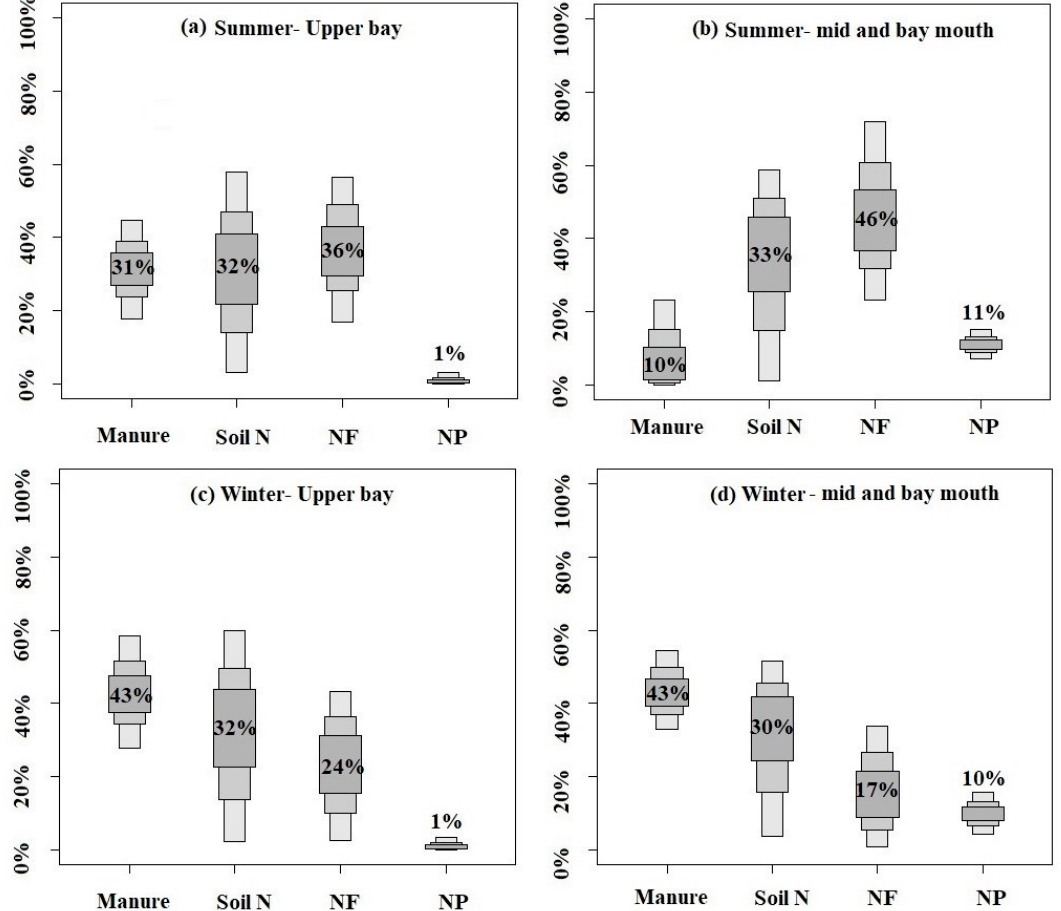
Figure 7. Proportional contributions of the four potential nitrate (NO 3 − ) sources in Zhanjiang Bay, estimated by the Bayesian isotope mixing model, namely N fertilizer (NF), soil N, manure, and N in precipitation (NP). ( a ) NO 3 − sources in the upper bay during summer, ( b ) NO 3 − sources in the mid-bay and bay mouth during summer, ( c ) NO 3 − sources in the upper bay during winter, and ( d ) NO 3 − sources in the mid-bay and bay mouth during